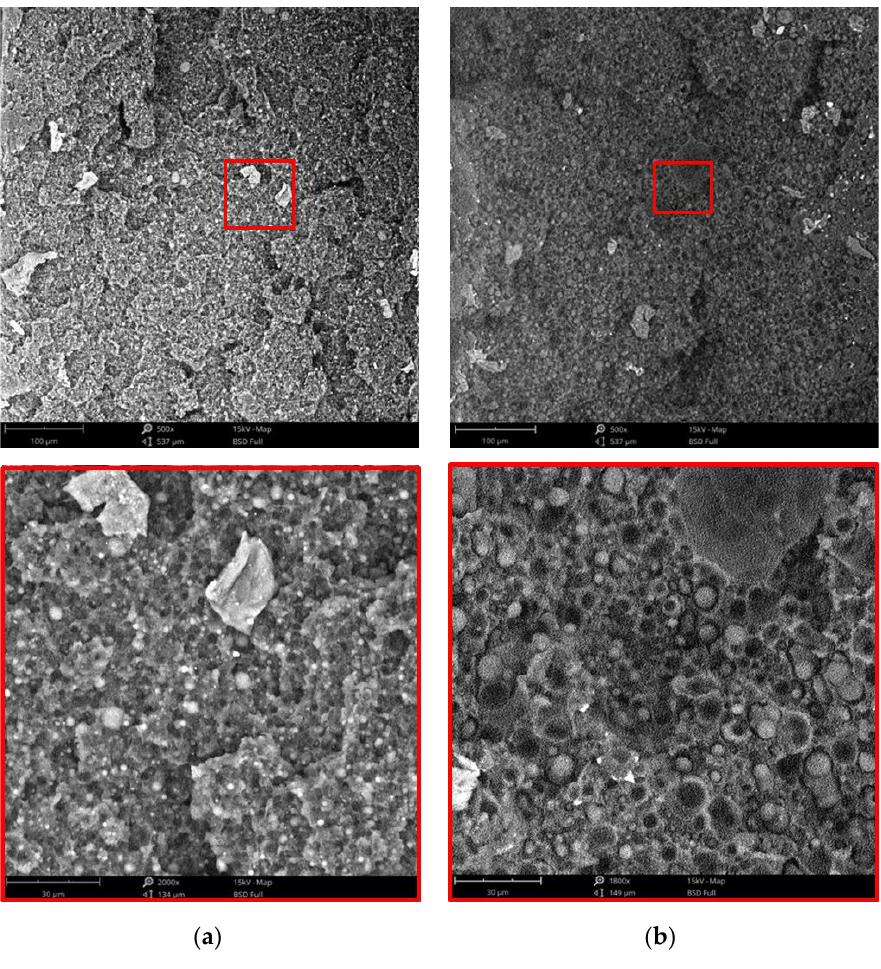
Figure 9. SEM micrographs: ( a ) A3/1, ( b ) A3/5 blends.